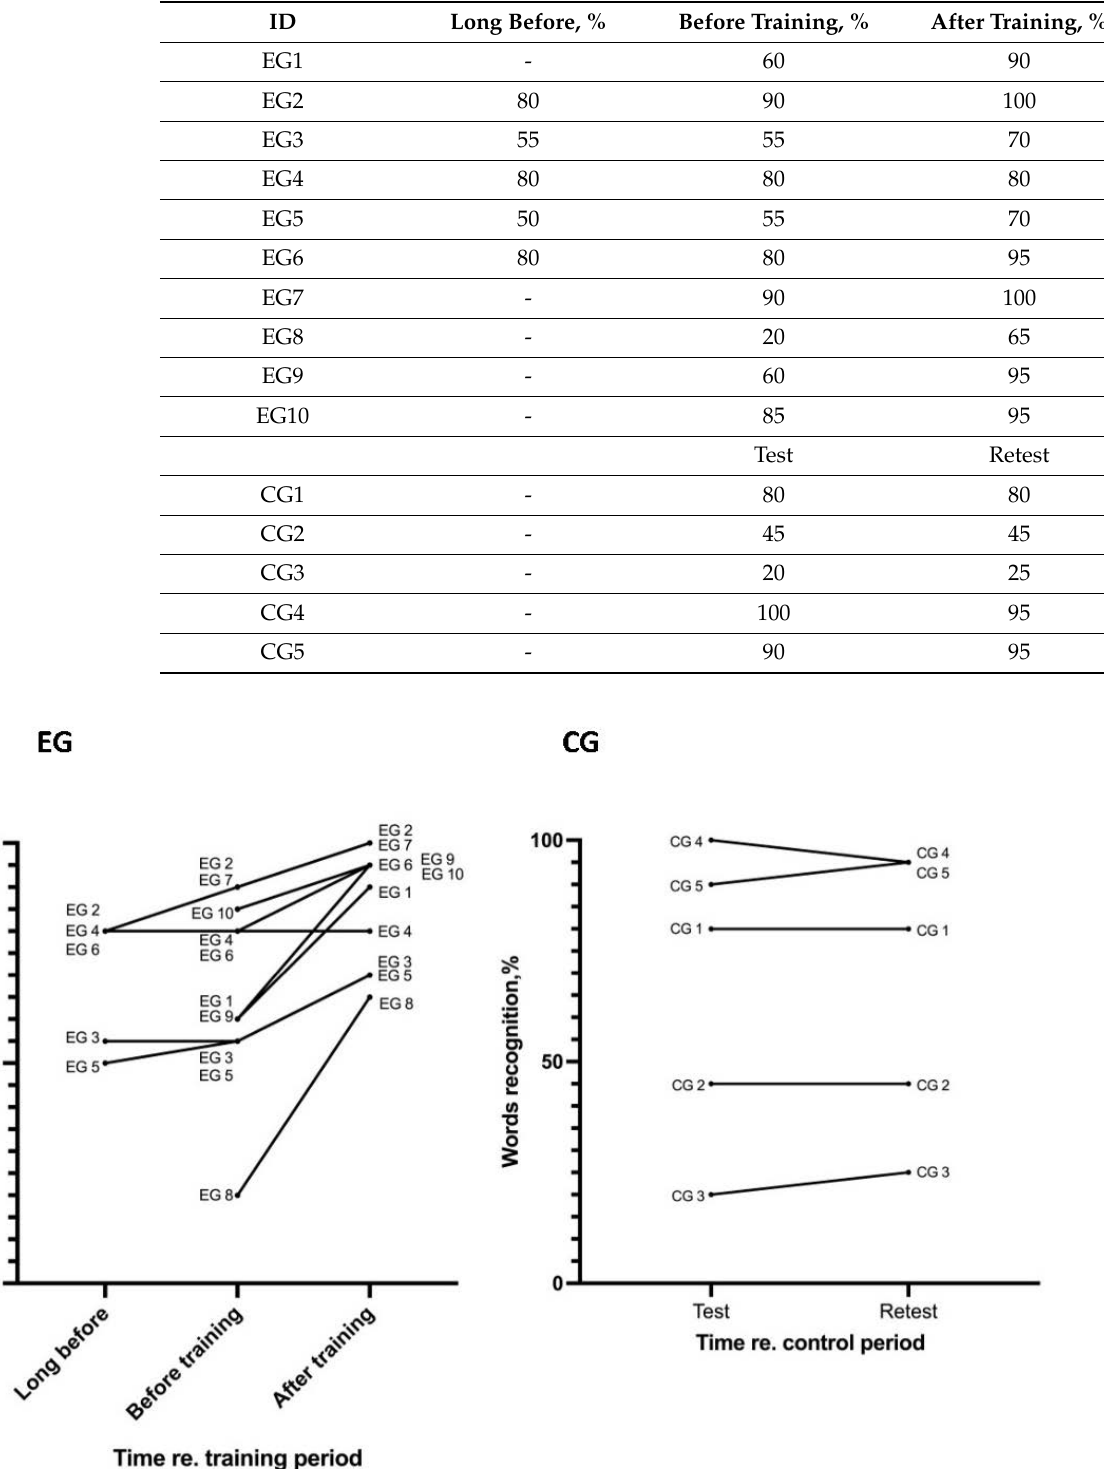
Table 3. Word recognition data.